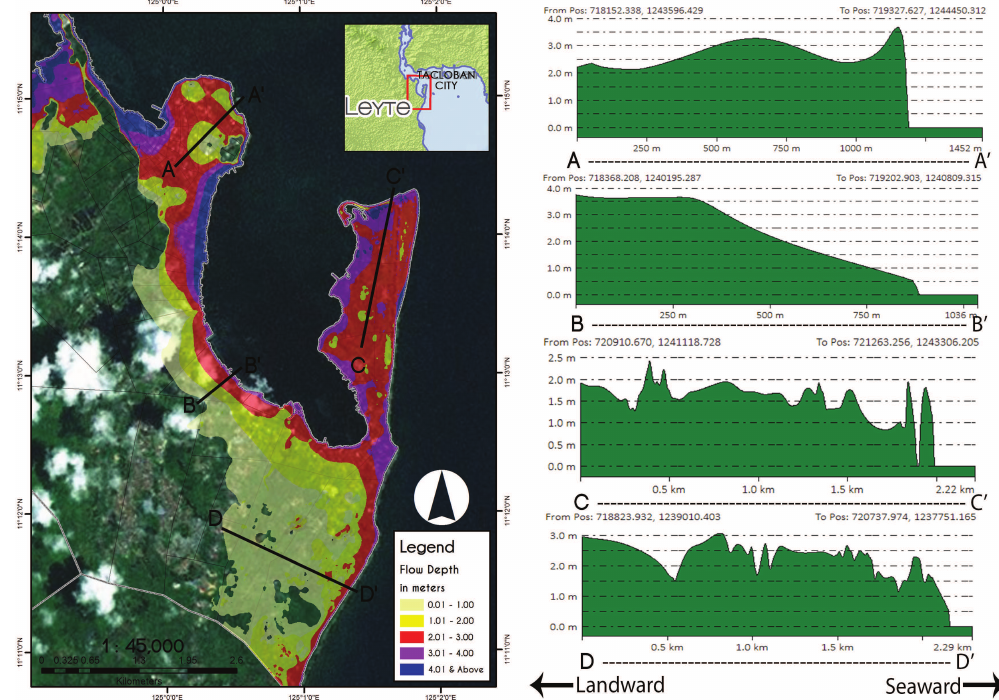
Figure 7. Leyte inundation map with topographic elevation profiles at the marked transects (variable y axis scale to clearly display the local variation in